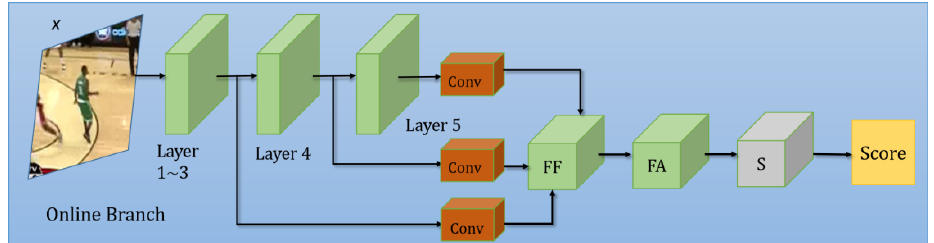
Figure 3. The online training (OT) branch of our network.